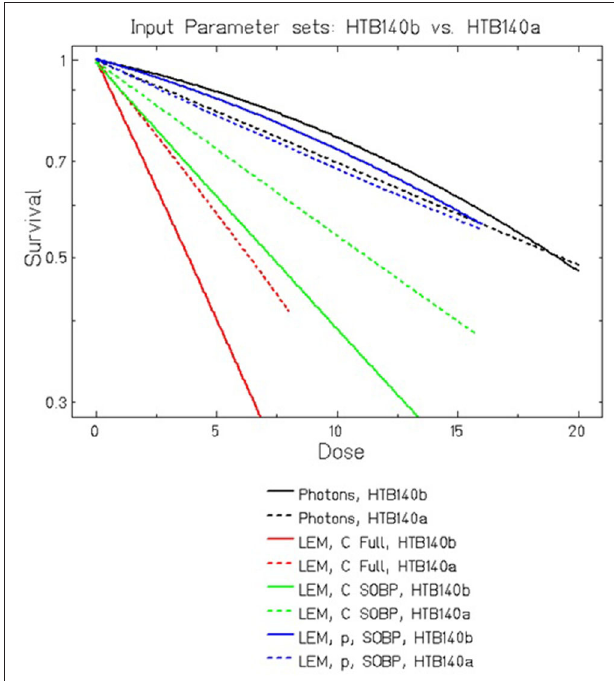
FIGURE 3 | Comparison of LEMIV model calculations for cell killing of HTB140 cells using two different input data sets (see Table 1 ). For carbon ions at high LET, even in the case of β photon = 0 Gy − 2 a substantially increased RBE is predicted, which is further enhanced if β photon > 0 is